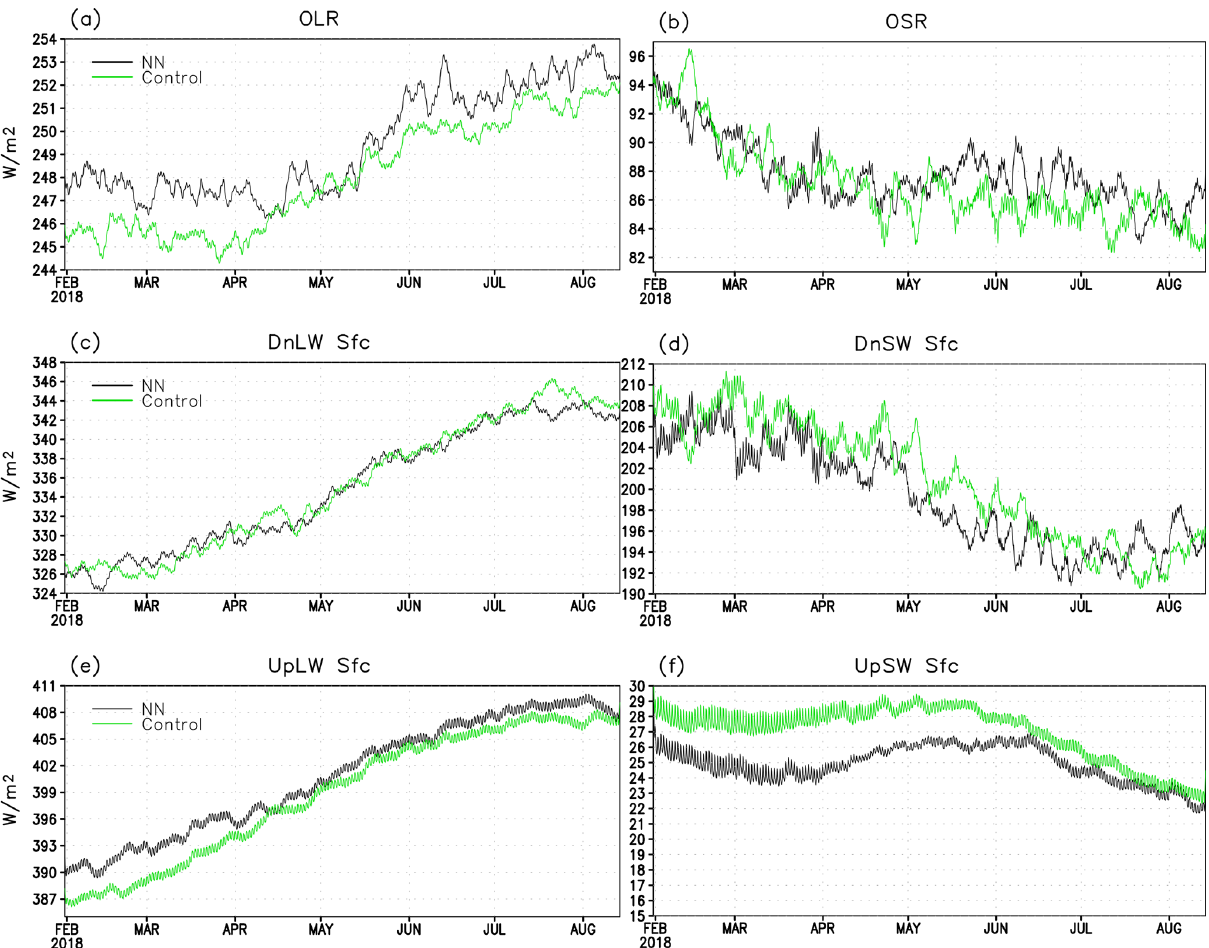
Figure 4. Time series of a running 10d mean covering 1 February–1 August 2018 for (a) outgoing LW at TOA, (b) outgoing SW at TOA, (c) downwelling LW radiation at the surface, (d) downwelling SW radiation at the surface, (e) upwelling LW radiation at the surface, and (f) upwelling SW radiation at the surface. Black curves – results produced by HGFS; green – results by